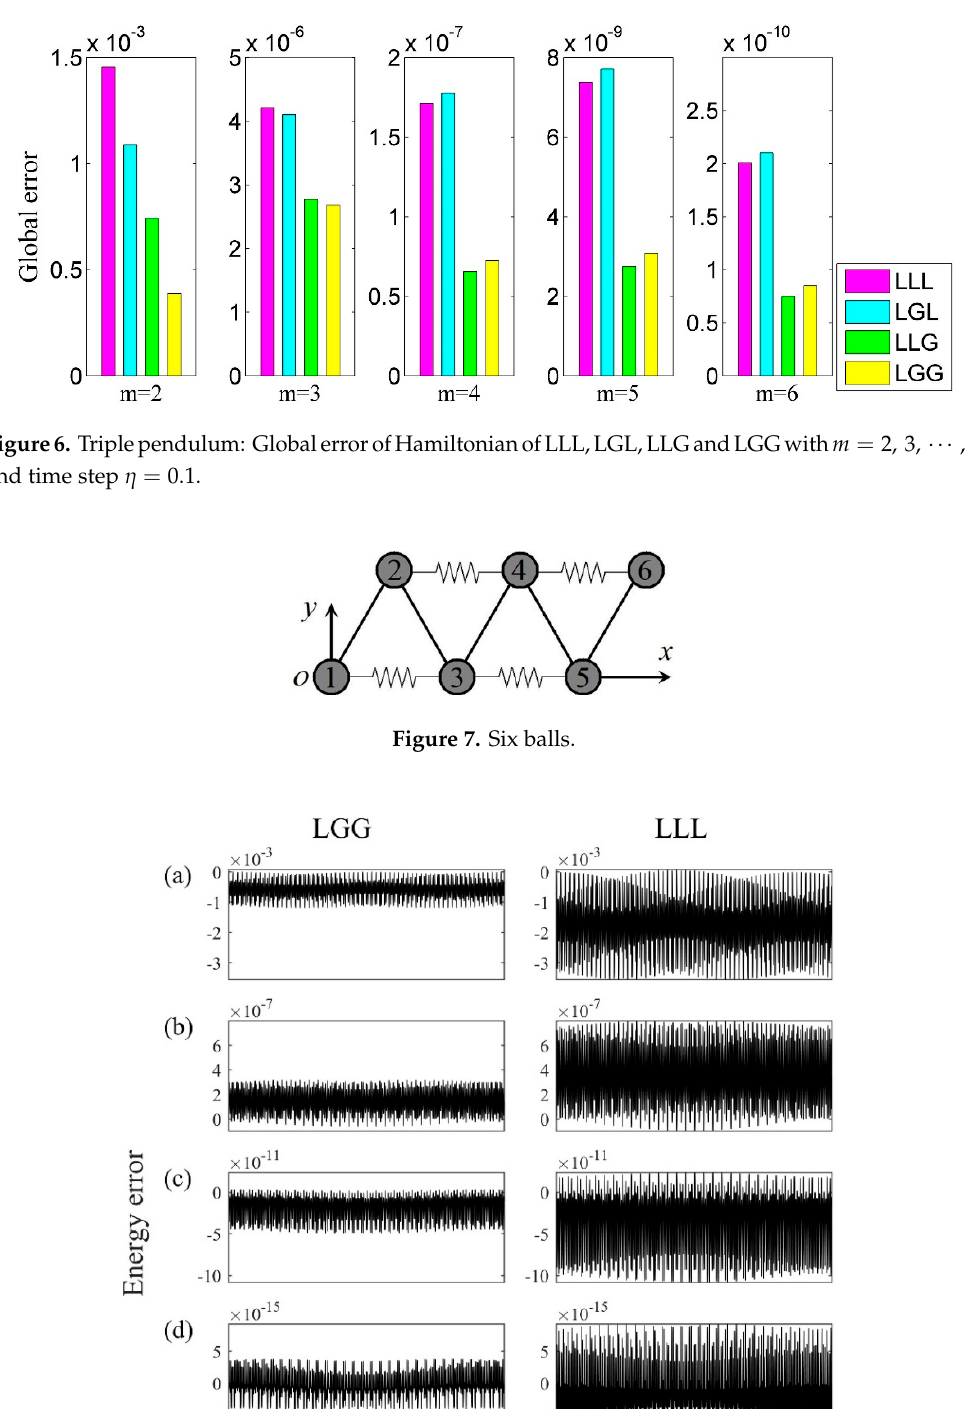
Figure 7. Six balls.